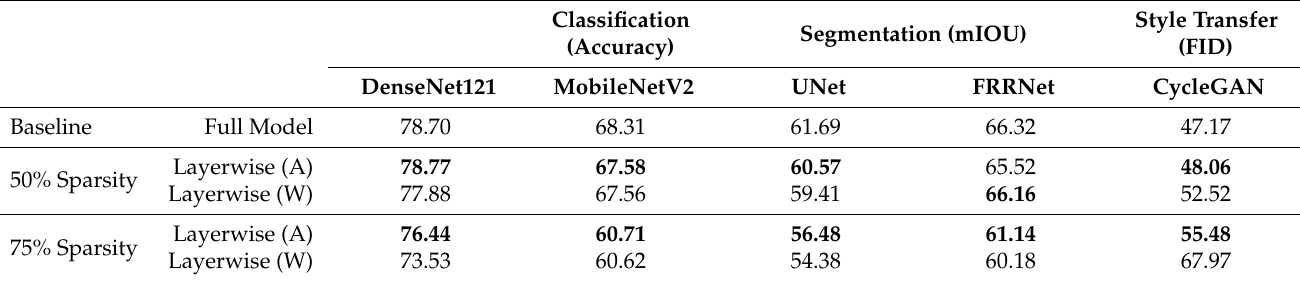
Table 2. Comparing data-free vs. data-driven neuron importance measures across discriminative and generative tasks using our greedy layerwise channel pruning algorithm, we observe that the mean (cid:96) 1 -norm of the output activations (i.e., “Layerwise (A)”) performs better than the (cid:96) 1 -norm of channel weights (i.e., “Layerwise